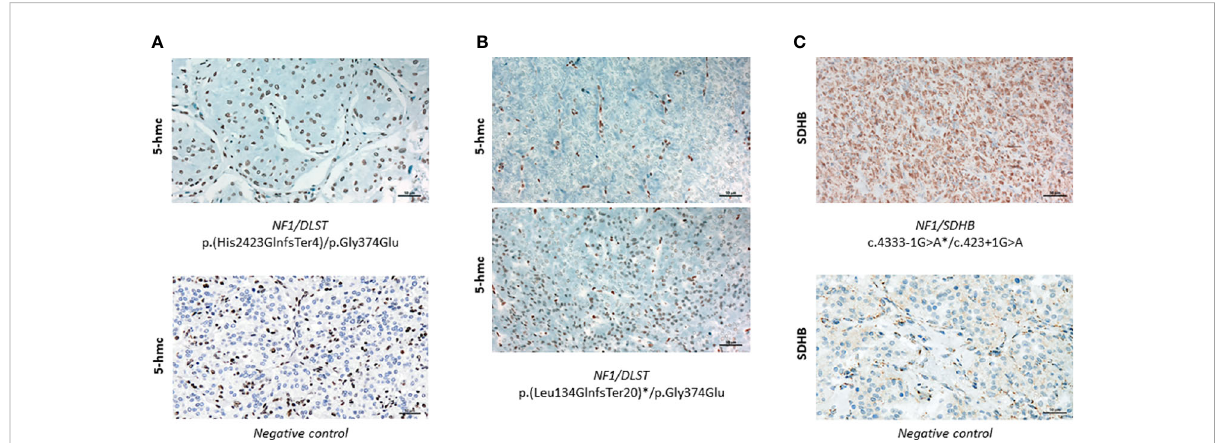
FIGURE 3 (A) Positive 5-hmC IHC performed in case 1 (upper panel) compared to a negative control (lower panel) (x20). (B) 5-hmC IHC performed in case 24, showing patches of negative (upper panel) and positive (lower panel) staining (x20) (C) Positive SDHB IHC performed in the tumour carrying SDHB / NF1 dual germline mutations (upper panel) compared to a negative control (lower panel) (x20). Asterisks denote a somatic